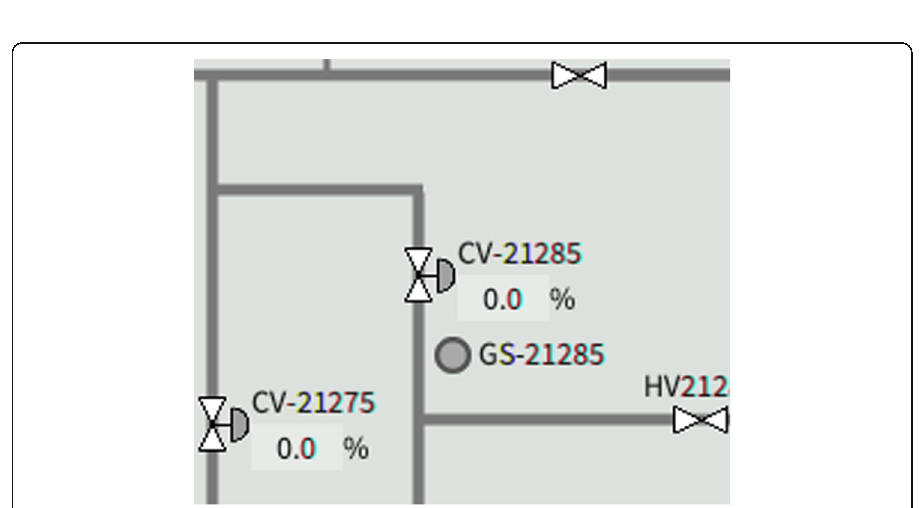
Fig. 10 Controlled objects